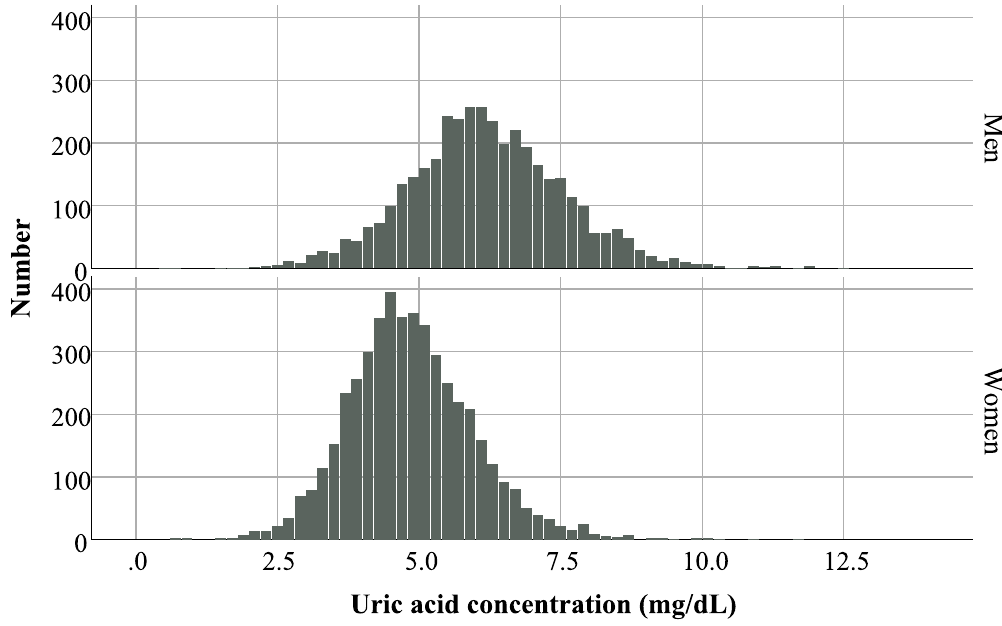
Fig 2. Histogram of baseline uric acid concentration by sex. Sex difference in uric acid concentration is prominent. In the histogram, the baseline uric acid concentration is distributed normally in both sexes. The mean (SD) values were 4.8 (1.1) mg/dL and 6.1 (1.4) mg/dL in women and men, respectively.